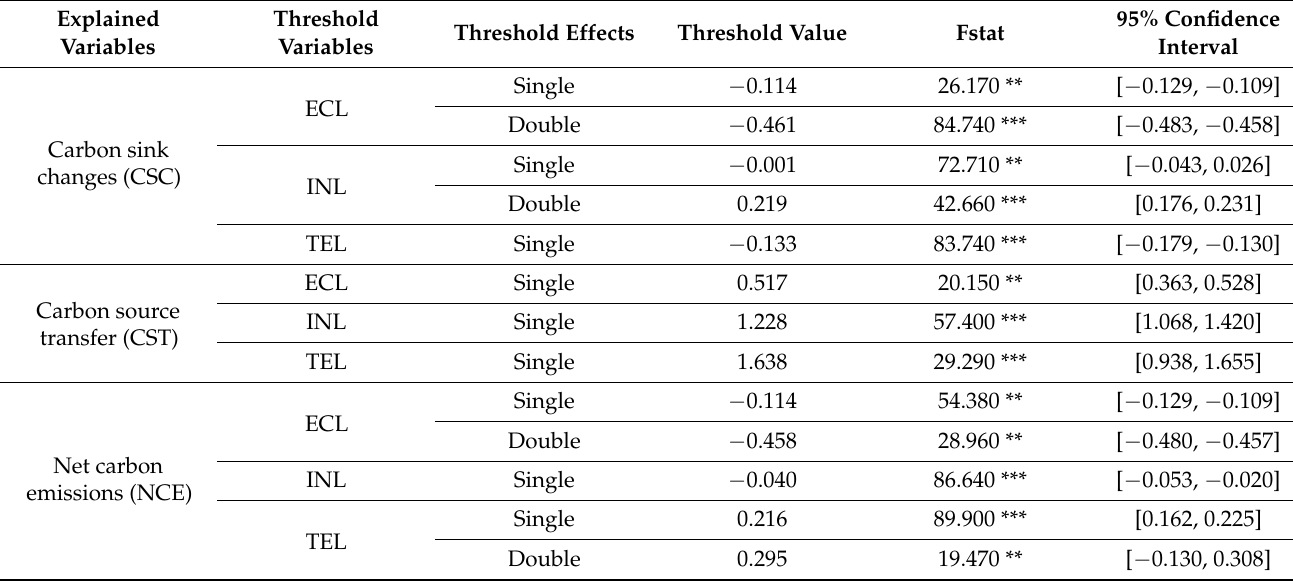
Table 5. Threshold effect test of carbon emission